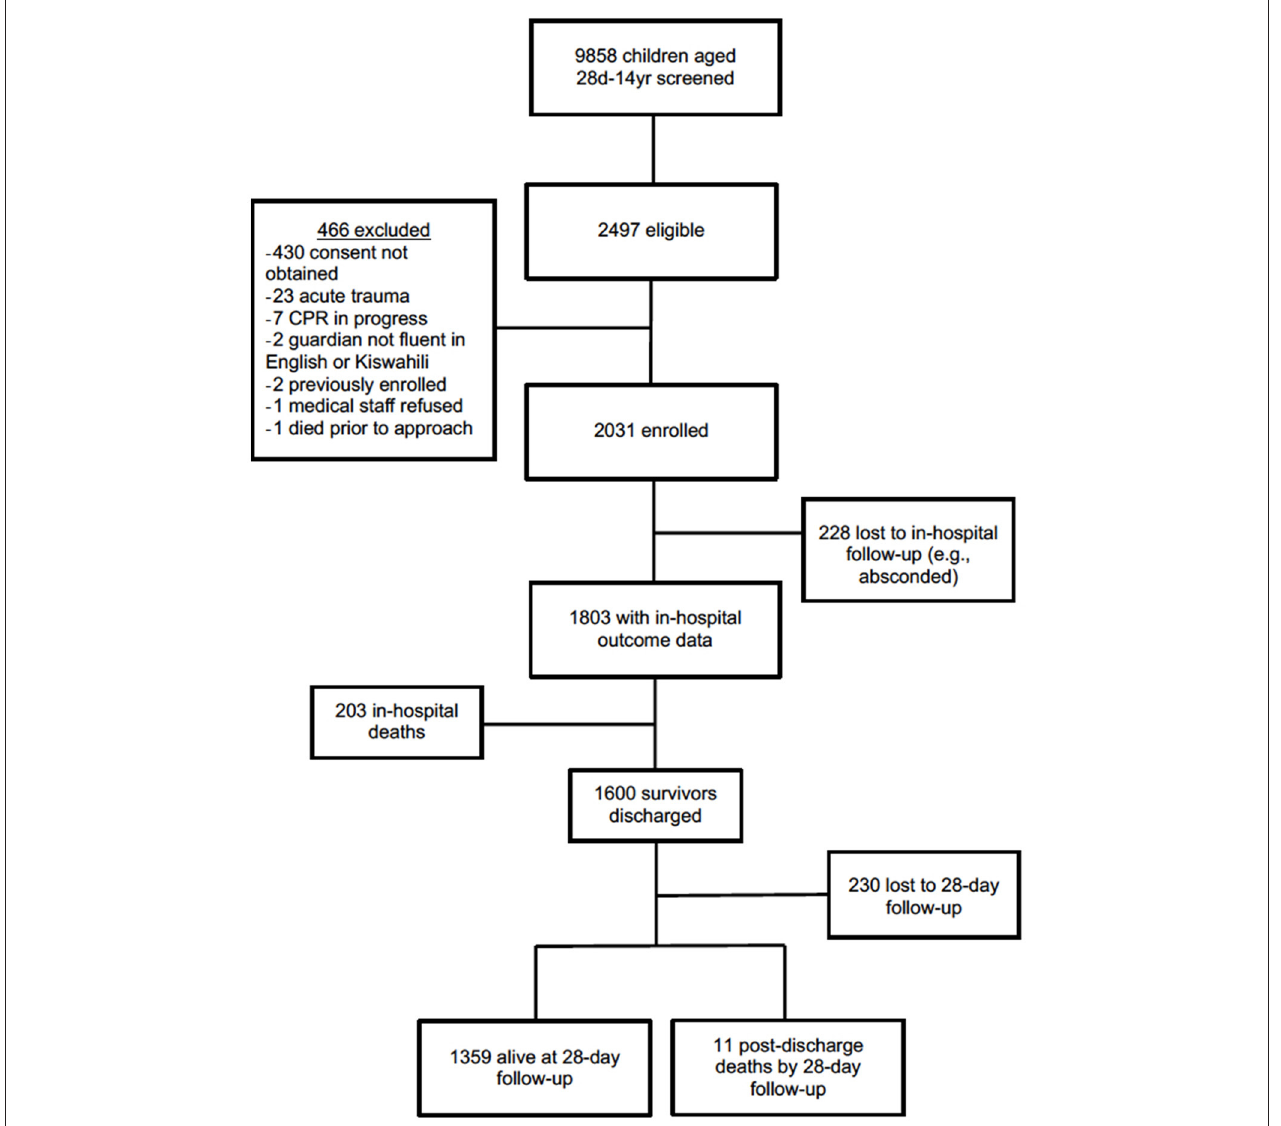
FIGURE 1 | Study cohort flowchart including screening, enrollment, and outcomes.